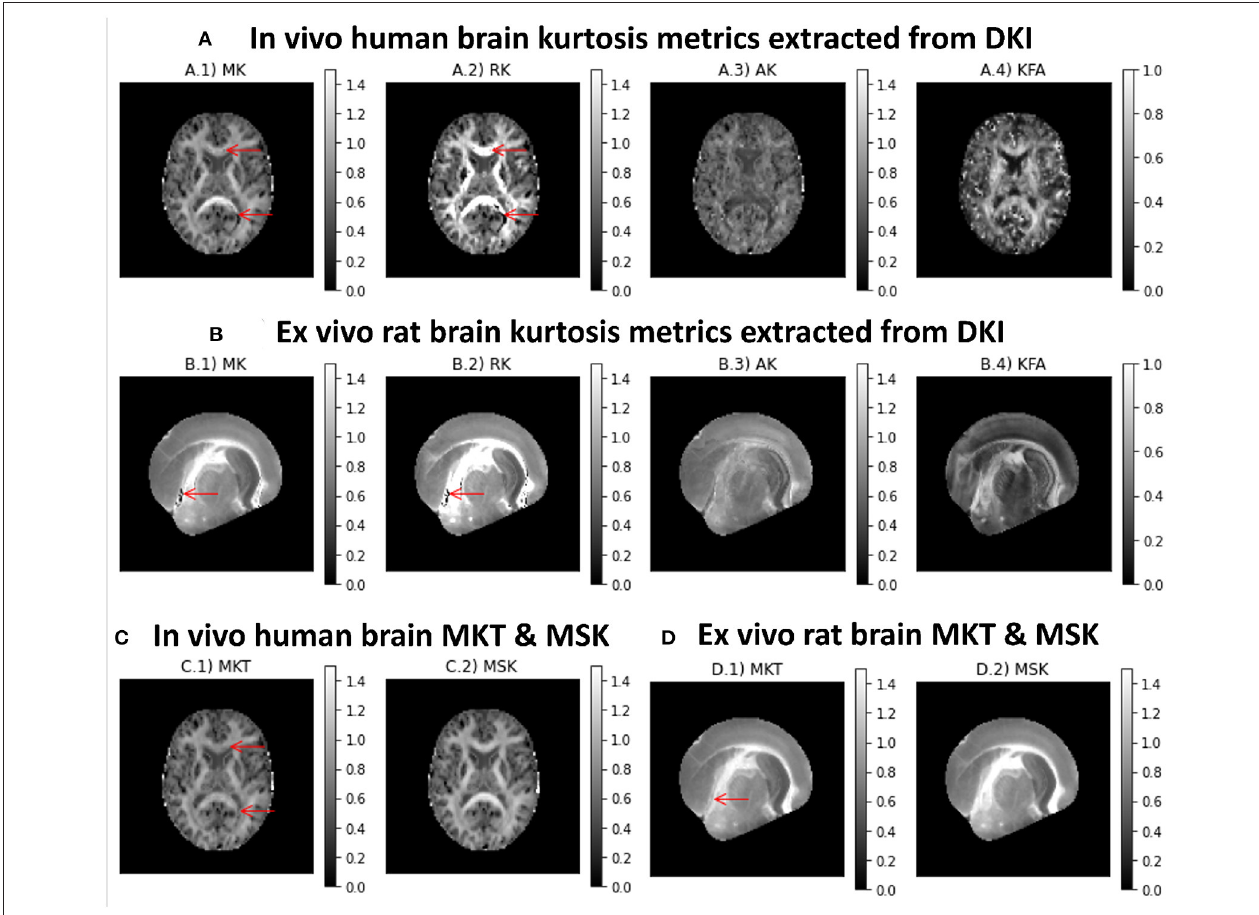
FIGURE 5 | Kurtosis metrics for a representative axial slice of the two CFIN datasets computed using the DIPY’s DKI and MSDKI implementations: (A) DKI diffusion metrics for the in vivo human brain dataset (A.1 Mean Kurtosis, A.2 Radial Kurtosis, A.3 Axial Kurtosis, A.4 Kurtosis Fractional Anisotropy); (B) DKI diffusion metrics for the ex vivo rat brain dataset (B.1 Mean Kurtosis, B.2 Radial Kurtosis, B.3 Axial Kurtosis, B.4 Kurtosis Fractional anisotropy); (C) mean kurtosis tensor and mean signal kurtosis maps for the in vivo human brain dataset (C.1, C.2, respectively); (D) mean kurtosis tensor and mean signal kurtosis maps for the ex vivo rat brain dataset (D.1,D.2,